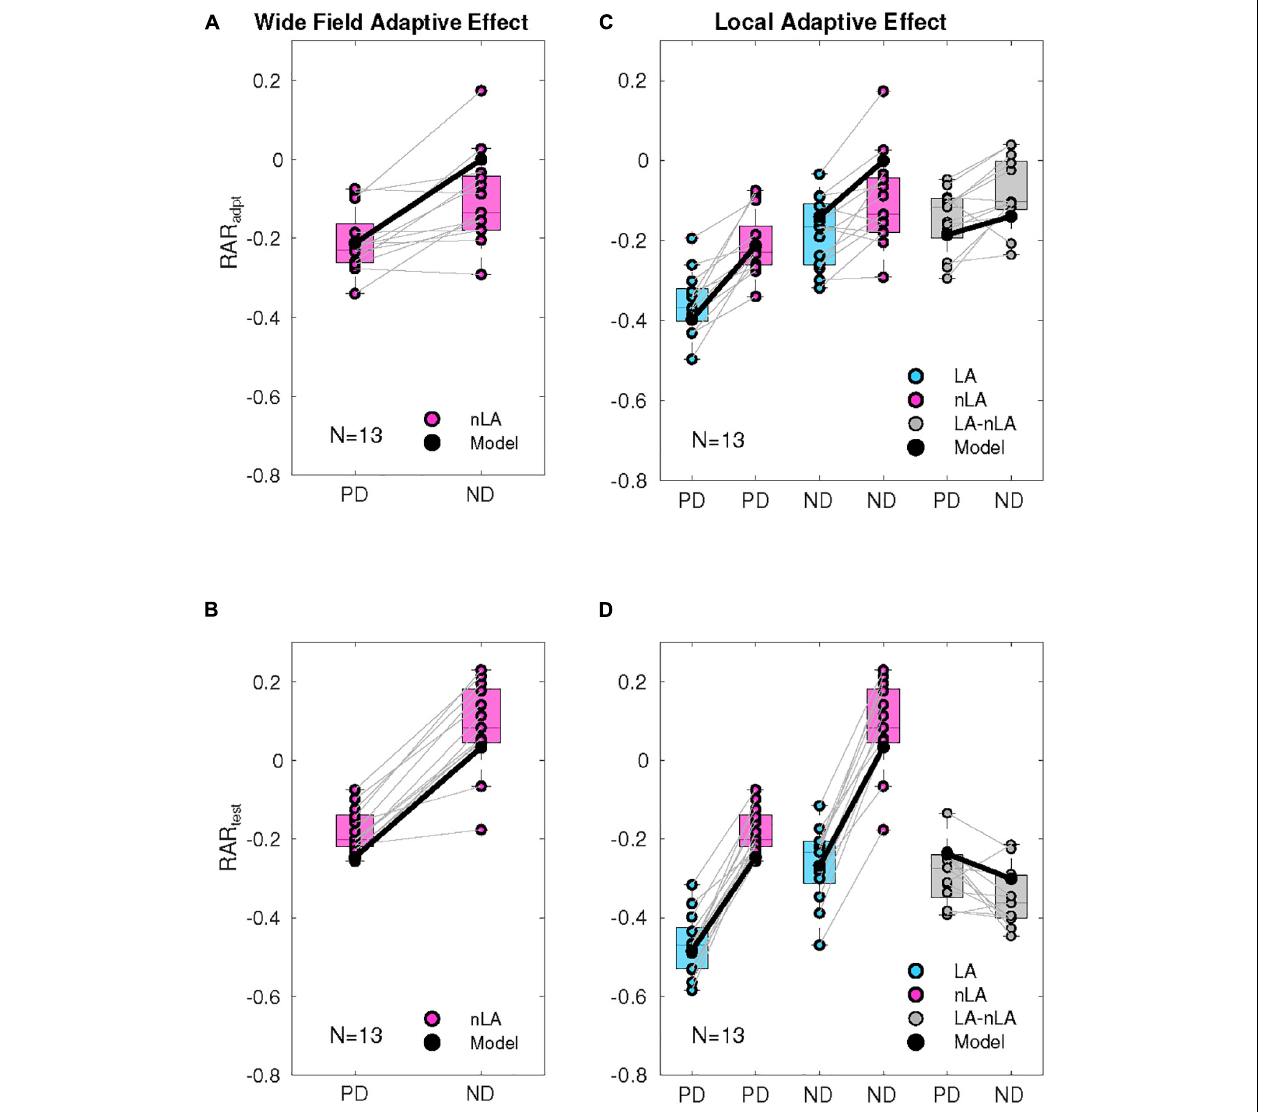
FIGURE 4 | Quantification of wide-field and local adaptation. (A) Relative amplitude reduction of the response during motion adaptation (RAR adpt ): Consequences of wide-field adaptation determined by comparing the response at the end and beginning of the adaptation phase. The response level at the beginning and end of the wide-field motion adaptation period (nLA) was determined by averaging over 400 ms periods starting 100 ms after the start of the adaptation period or terminating at its end. The response decrement during the adaptation period was normalized by the average reference response. The model responses (black dots) were treated in the same way. The adaptive effects are shown both pairwise for PD and ND adaptation of all 13 cells (magenta dots) and as box plots (mid-line, median, magenta box, 25–75 percentile). (B) Consequences of wide-field adaptation determined by comparing the test and reference responses and normalizing them to the average reference response. The averages were taken for the last 400 ms of the reference and test response, respectively. The first 100 ms were not included because of the initial response transient of the reference response. The model responses (black dots) were treated in the same way. The adaptive effects are shown both pairwise for PD and ND adaptation (nLA) for all 13 cells (magenta dots) and as box plots (mid-line, median, magenta box, 25–75 percentile). (C) Consequences of local adaptation during the adaptation period by comparing the responses obtained for both nLA (magenta) and LA (cyan). The responses under the LA condition were determined in the way as described in panel (A) for the nLA condition. The model responses (black dots) were treated in the same way as the experimentally determined responses. The adaptive effects for the LA and nLA conditions are shown pairwise [nLA: same data as in panel (A) ] and as box plots (mid-line, median, box, 25–75 percentile). The data for PD adaptation are shown in the left, those for ND adaptation in the middle. On the right, the corresponding differences between the adaptive effects obtained under the LA and nLA conditions, respectively, are shown in gray along with the model equivalents for both PD and ND adaptation. (D) Consequences of local adaptation by comparing the corresponding test and reference responses obtained for both nLA (magenta) and LA (cyan). The adaptive effects were normalized to the average reference response. The responses under the LA condition were determined in the way as described in panel (B) for the nLA condition. The model responses (black dots) were treated in the same way as the experimentally determined responses. The adaptive effects for the LA and nLA conditions are shown pairwise [nLA: same data as in panel (B) ] and as box plots (mid-line, median, box, 25–75 percentile). The data for PD adaptation are shown in the left, those for ND adaptation in the middle. On the right, the corresponding differences between the adaptive effects obtained under the LA and nLA conditions, respectively, are shown in gray along with the model equivalents for both PD and ND adaptation.